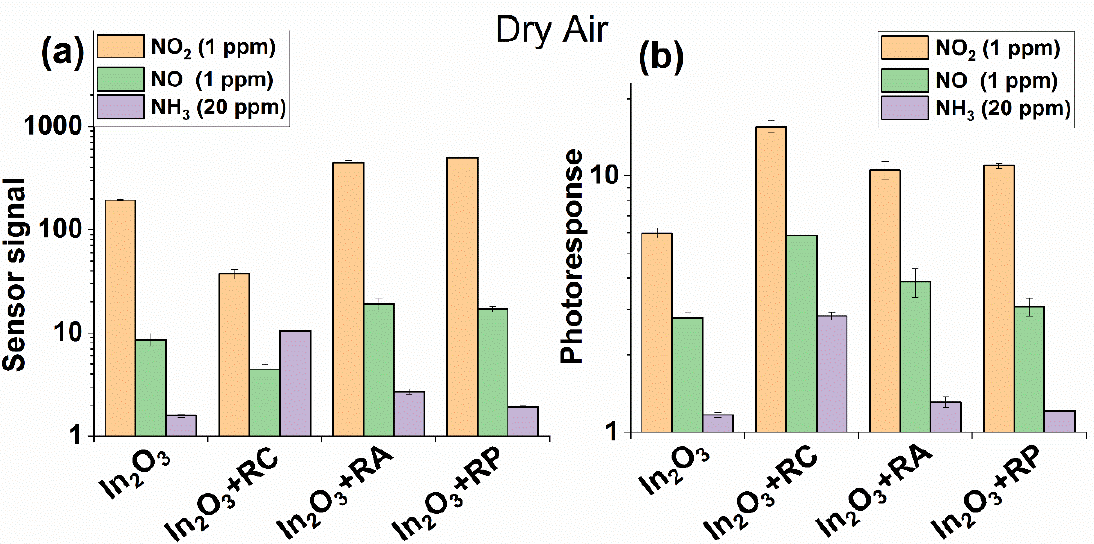
Figure 7. Comparison of the sensor signal ( a ) and photoresponse ( b ) of the samples towards different concentrations of NO 2 , NO, and NH 3 at room temperature in dry air.